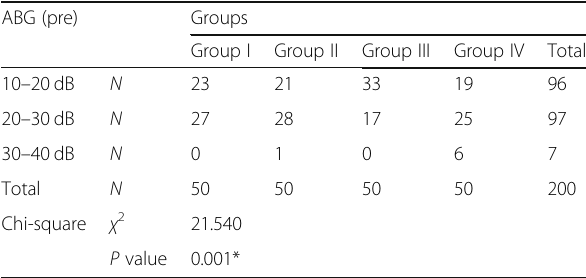
Table 1 Preoperative ABG for all patients ABG (pre) Groups